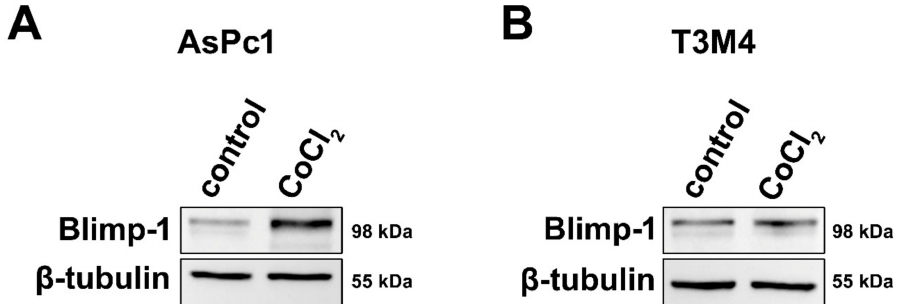
Figure 2. Cell culture. ( A ) Western blots showing markedly increased Blimp-1 expression in AsPc1 cells following treatment with CoCl 2 compared to vehicle control. ( B ) Treatment with CoCl 2 only induced a slight increase in Blimp-1 expression in T3M4 cells.